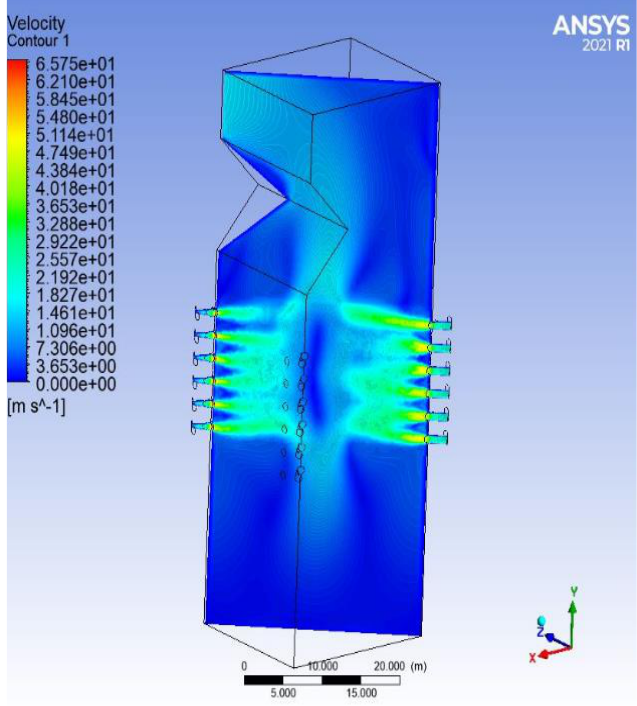
Figure 11. Velocity distribution of flue gas in case-IV.